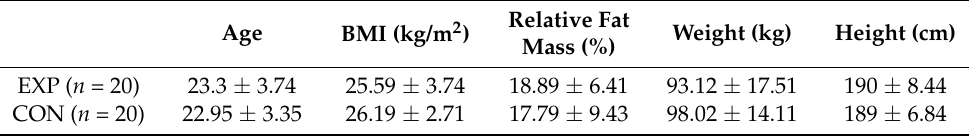
Table 1. Characteristics of study